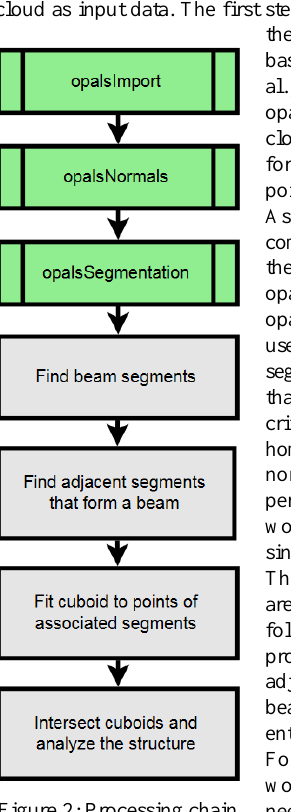
Figure 2: Processing